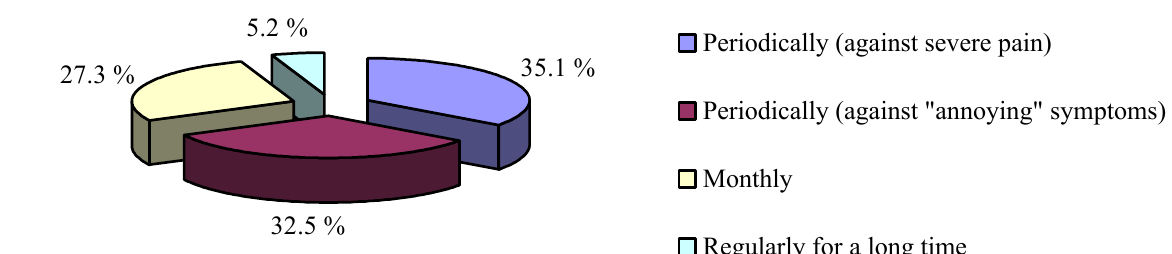
Fig. 1. The most common symptoms ( n =13) of PMS in the study participants: * the total percentage does not equal 100 % because the responders could choose a few answers simultaneously